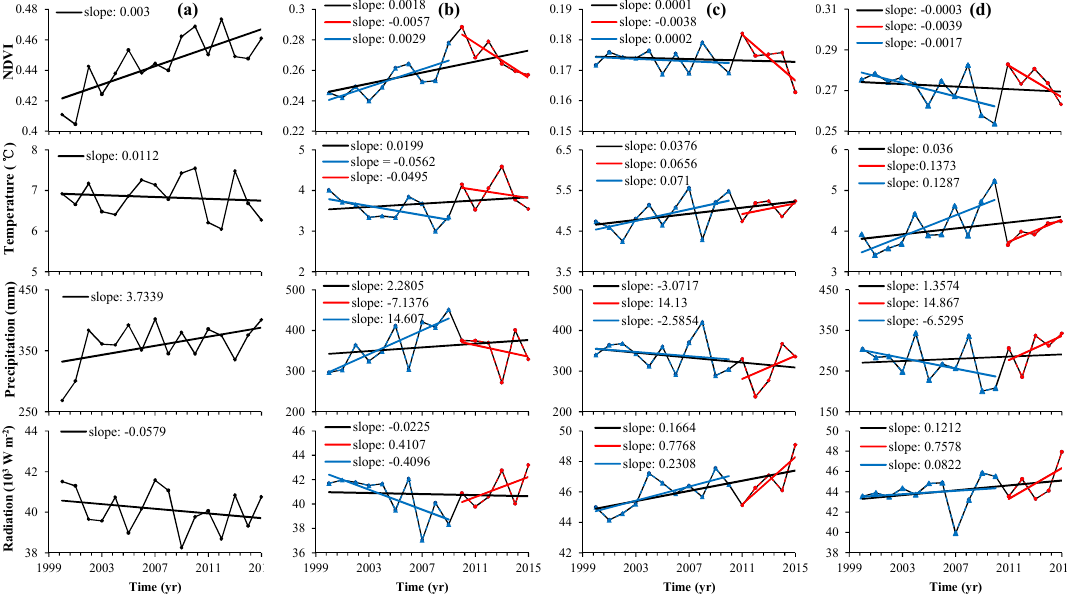
Figure 8. Inter-annual variations of growing season NDVI (GNDVI) and the related climate variables considering time-lag effects in the following ecosystem zones: IIC2 ( a ), IC1 ( b ), IC2 ( c ), and IIC1 ( d ). The black solid line indicates linear fits for the period of 2000–2015. The green and red solid lines represent linear fits before and after the breakpoint of GNDVI according to Figure 4, respectively.